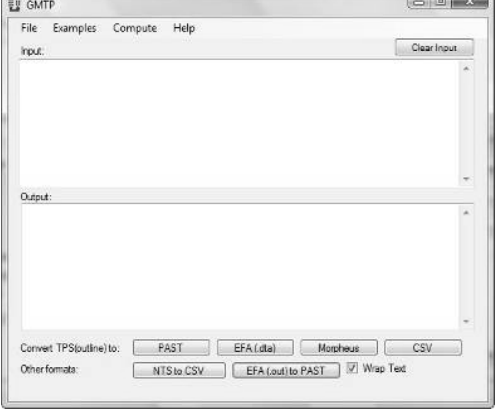
F IGURE 3.- Geometric Morphometric Tools Package (GMTP) screenshot